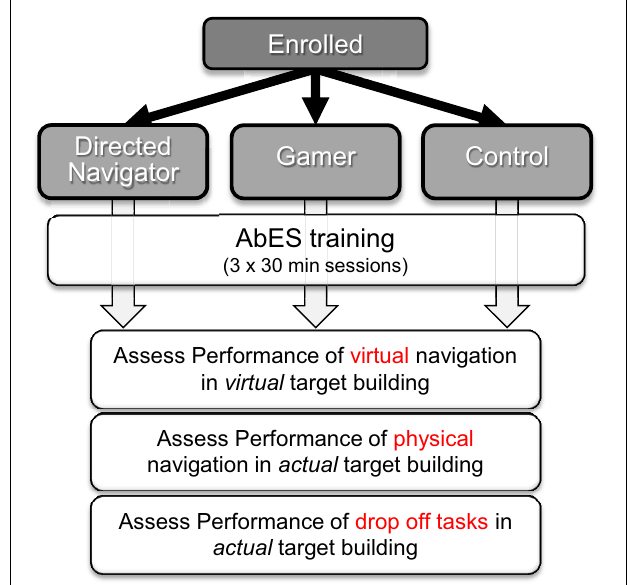
FIGURE 1 | Overall study design. Using a stratified randomization strategy, early and late blind participants were relegated to one of three experimental groups; (1) gamers (2) directed navigators, or (3) control. Training included 3, 30-min sessions. Following game play/training, the participants underwent a series of three sequential behavioral task assessments.